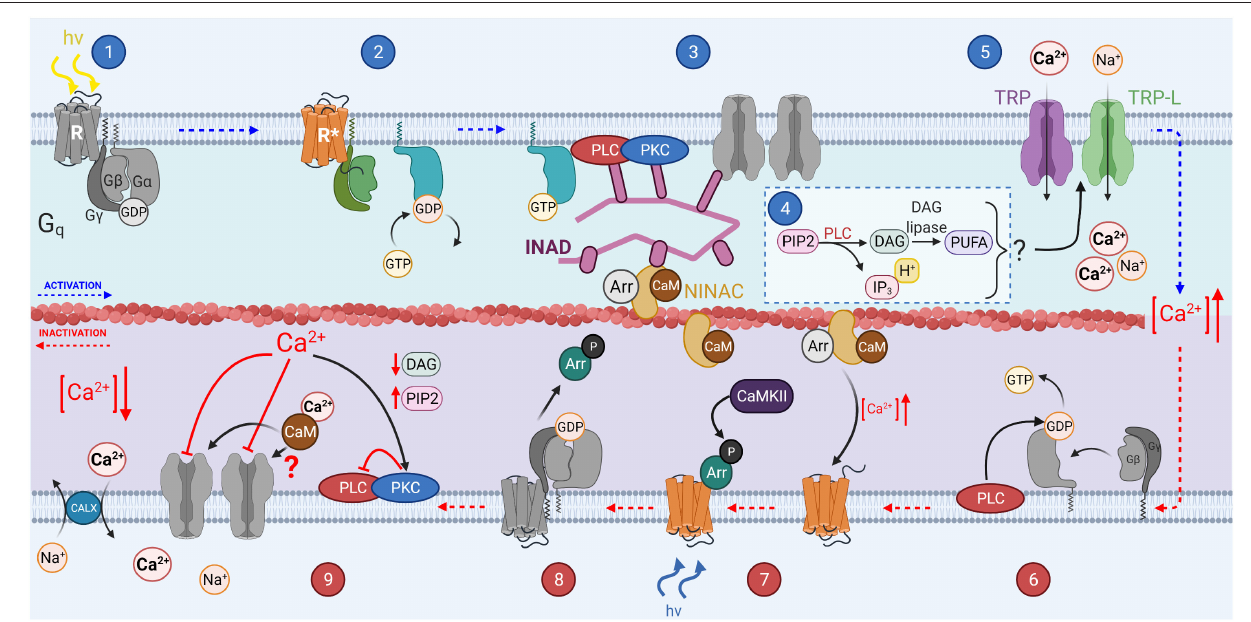
FIGURE 4 | The invertebrate phototransduction cascade, inactivation, and adaptation mechanisms: A photon causes isomerization of the chromophore 3-hydroxy 11- cis -retinal to 3-hydroxy all- trans -retinal (step 1). This activates the opsin (step 2), which also activates the G q α subunit through GDP-GTP exchange. The G q α subunit then activates membrane bound PLC (step 3), which hydrolyzes PIP 2 to produce IP 3 , DAG and H + (step 4), and potentially DAG is further catalyzed to produce PUFAs. Some or all the products from step 4 activate the membrane bound TRP and TRP-L channels in step 5, causing an influx of Ca 2 + and Na + ions, depolarizing the microvillus. PLC can act as a GTPase, hydrolyzing the GTP bound to G α to GDP (step 6). Invertebrate chromophore is bistable and is converted back from 3-hydroxy 11- cis retinal to 3-hydroxy-all- trans retinal at via the absorption of a second photon (step 7). CaMKII phosphorylates Arrestin 2 allowing it to dissociate from R* after the chromophore returns to its inactive state (step